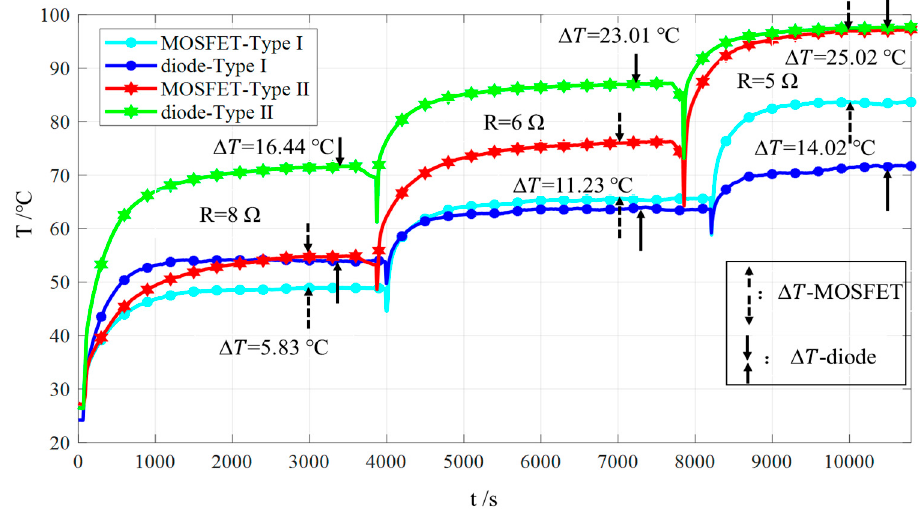
Figure 7. The comparisons of the case temperatures and the temperature differences of the power